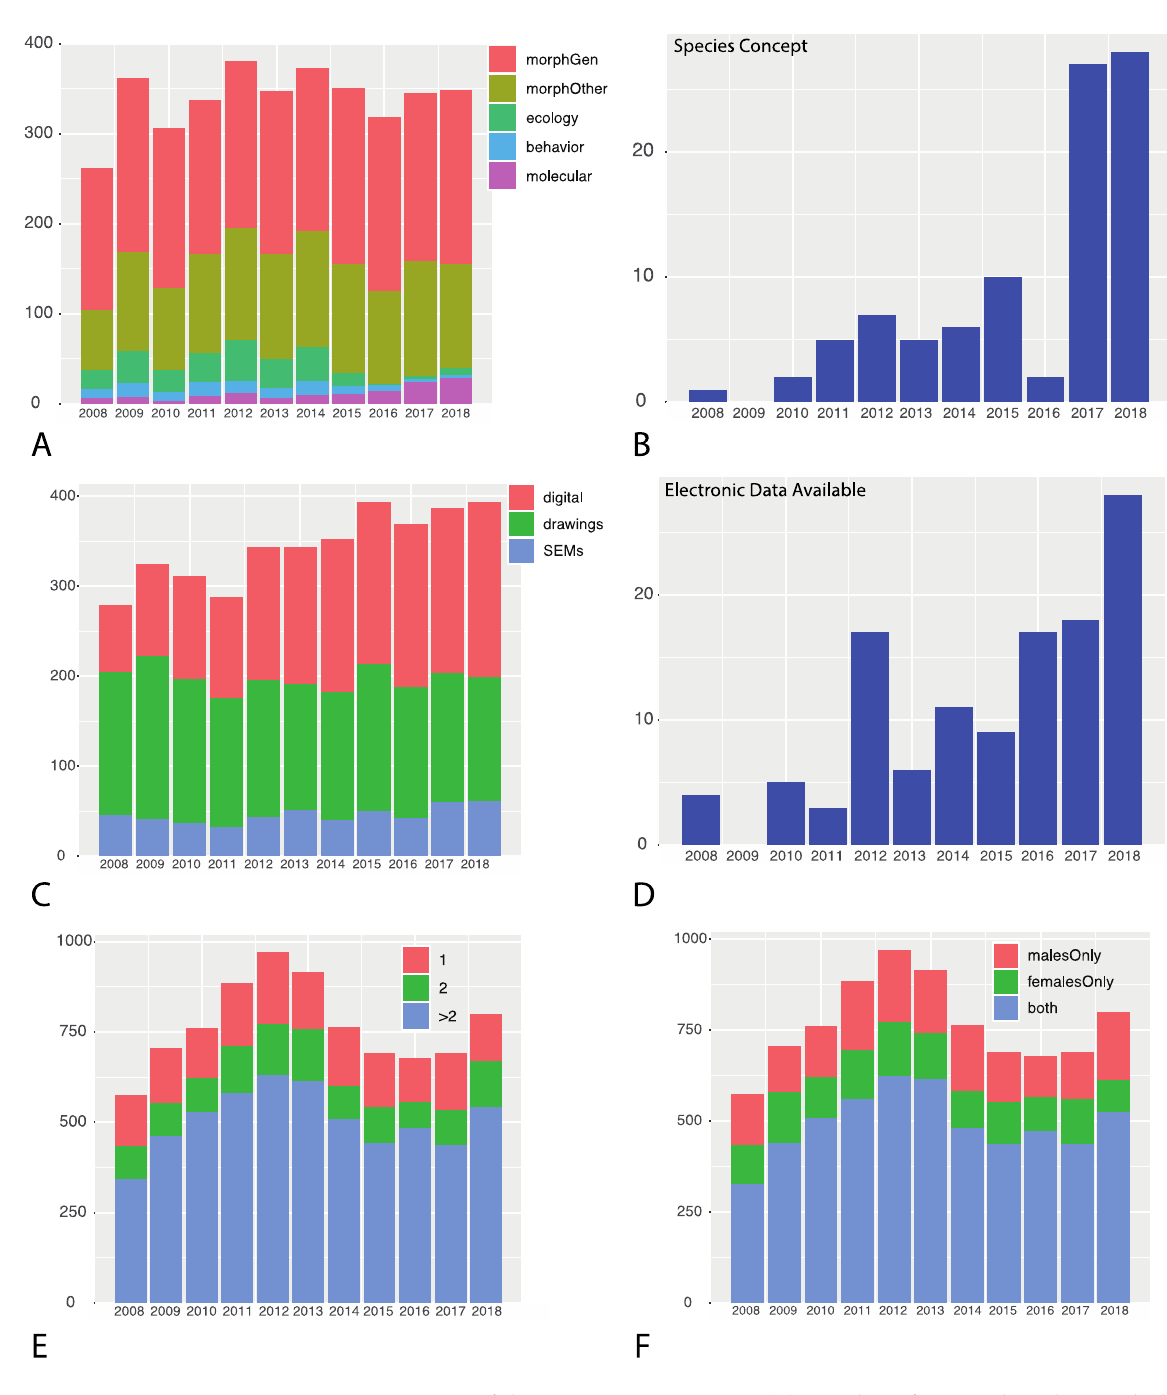
Figure 1. Summary of data per year 2008–2018. ( A ) Number of species based on each data type; ( B ) number of publications explicitly stating a species concept; ( C ) illustration type used in each publication; ( D ) prevalence of downloadable electronic data; ( E ) number of specimens examined per new species; ( F ) prevalence of both male and female specimens per new species described.